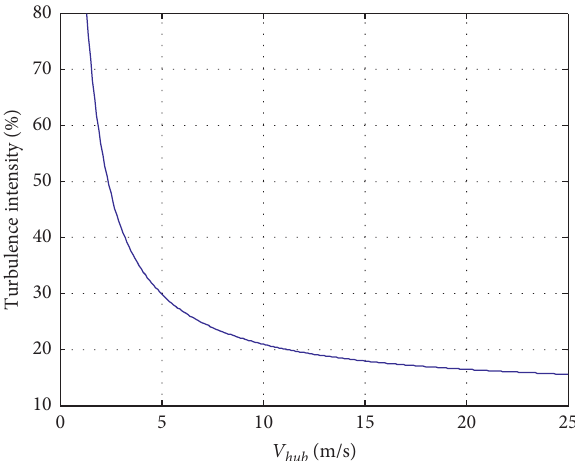
Figure 4: Turbulence intensity with different V